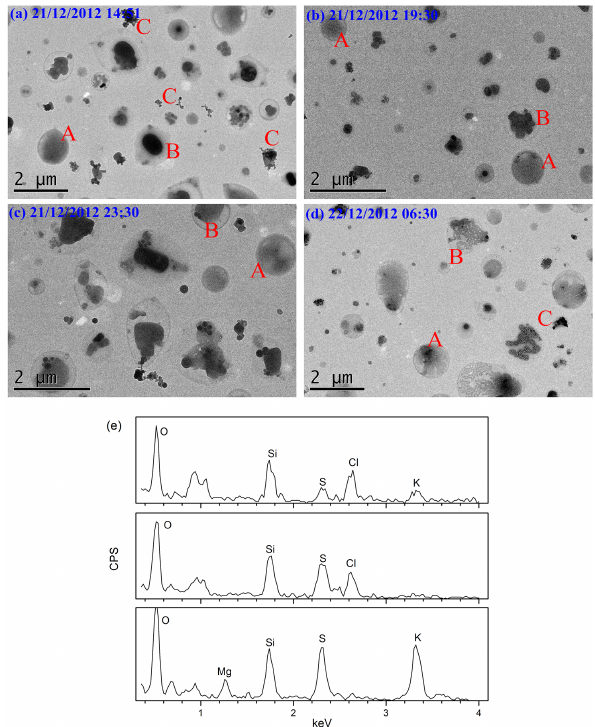
Figure 4. (a–d) Morphology and the mixing state of single particles in hazy days. The predominant particles are spherical ones without or with coating (types A and B), and in internal mixing state; some fresh and aged soot aggregates (type C) were also observed. (e) Ex- amples of elemental compositions in single particles collected. CPS is counts per